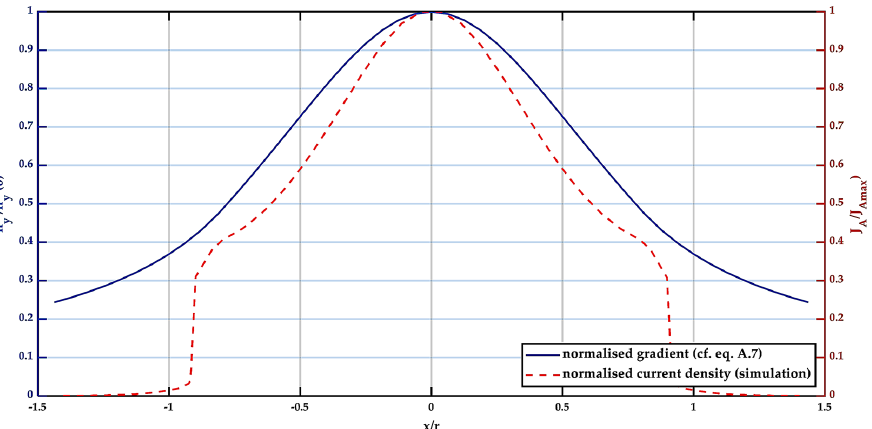
Figure 5. Comparison of normalized curves representing the change of current density across the diagonal of the VES-BJT transistor: on the ordinate axis, the distance from the centre of the device, normalized in relation to the characteristic radius r, on the abscissa axis, the normalized value of the derivative of the partial concentration of carriers ∂ n / ∂ y , with respect for maximal value n n 0 / w b 0 (left axis), and normalized diffusion current density from TCAD simulation (right axis). The solid line corresponds to the dimensions of the structure in w b 0 = 250 nm, r = 450 nm; the dashed line corresponds to the device with the same dimensions obtained from TCAD